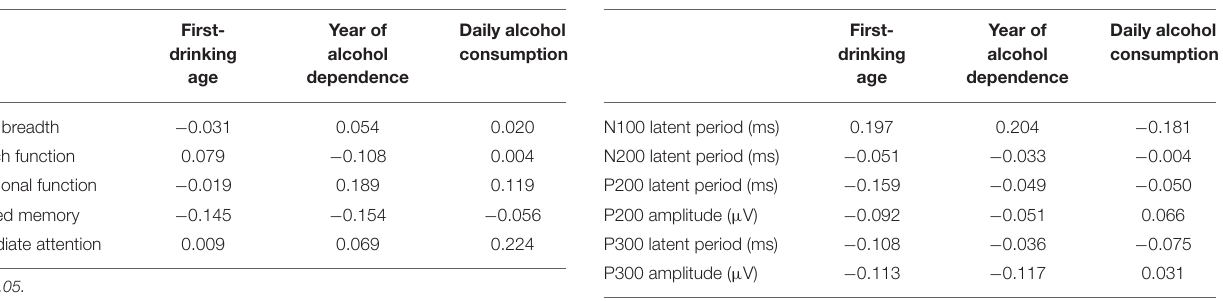
TABLE 3 | Analysis of the correlation between the first-drinking age, year of alcohol dependence, daily alcohol consumption, and RBANS scores in the alcohol-dependence group.